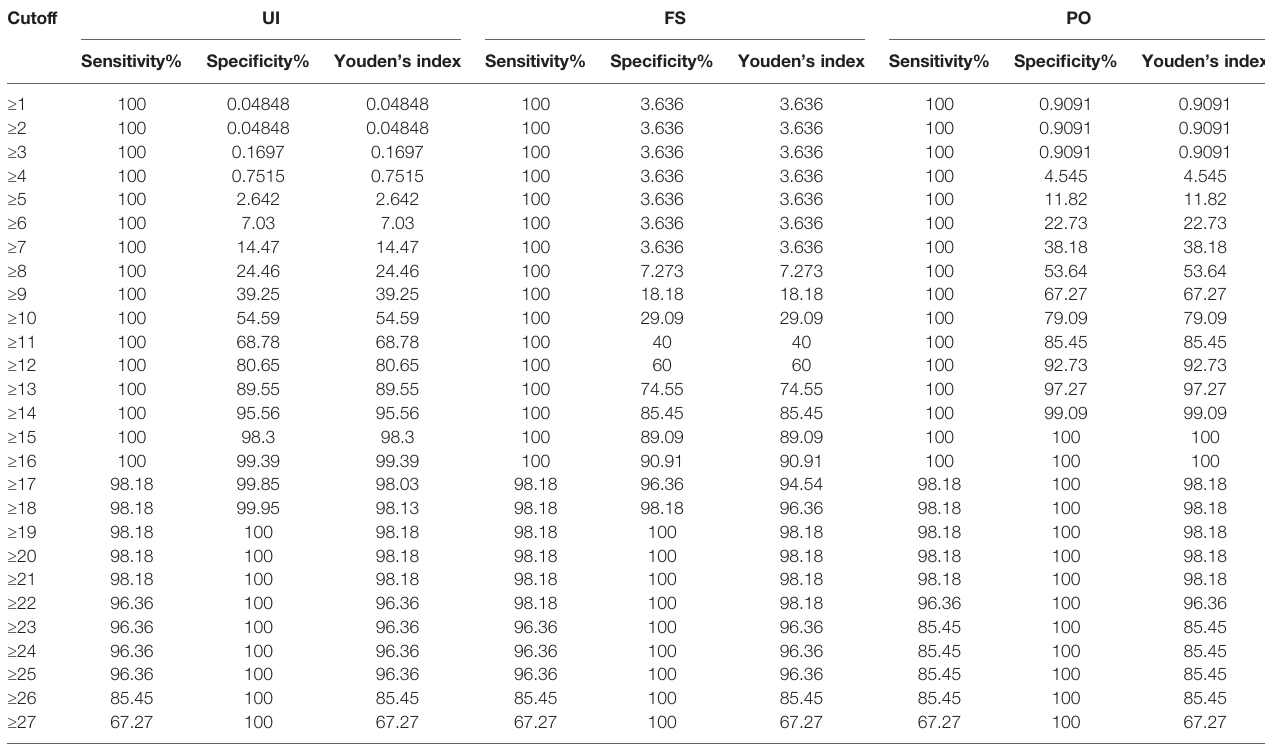
TABLE 1 | Sensitivity, speci fi city, and Youden ’ s index at various cutoff points of A 2 . Cutoff UI